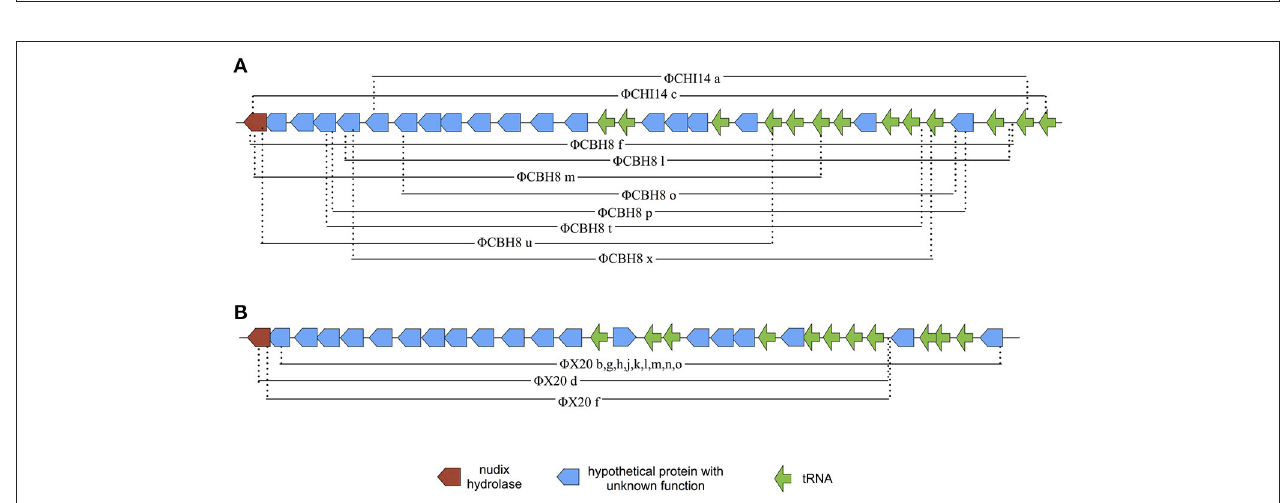
FIGURE 3 | Alignment of the primary sequence of AsiA encoded in 8 CHI14 and 8 CBH8 wild type and escape phages. Blue highlight indicates identical sequences while yellow highlight shows variations in the primary sequence of AsiA in escape mutants.